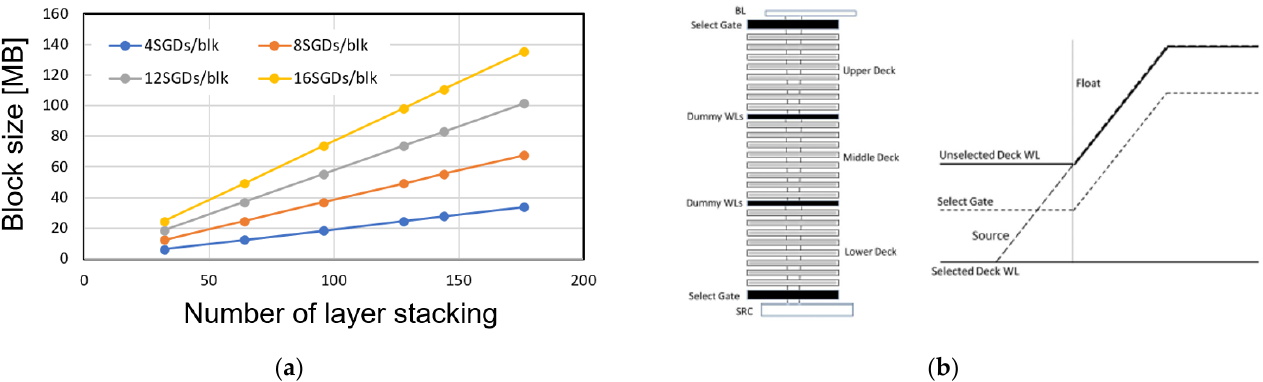
Figure 23. ( a ) Block size scaling as a function of number of layer stacking. ( b ) Block-by-deck erase scheme. The conventional physical block is divided into three logical blocks [30]. Reprinted with permission from ref. [23], Copyright 2021 IEEE.